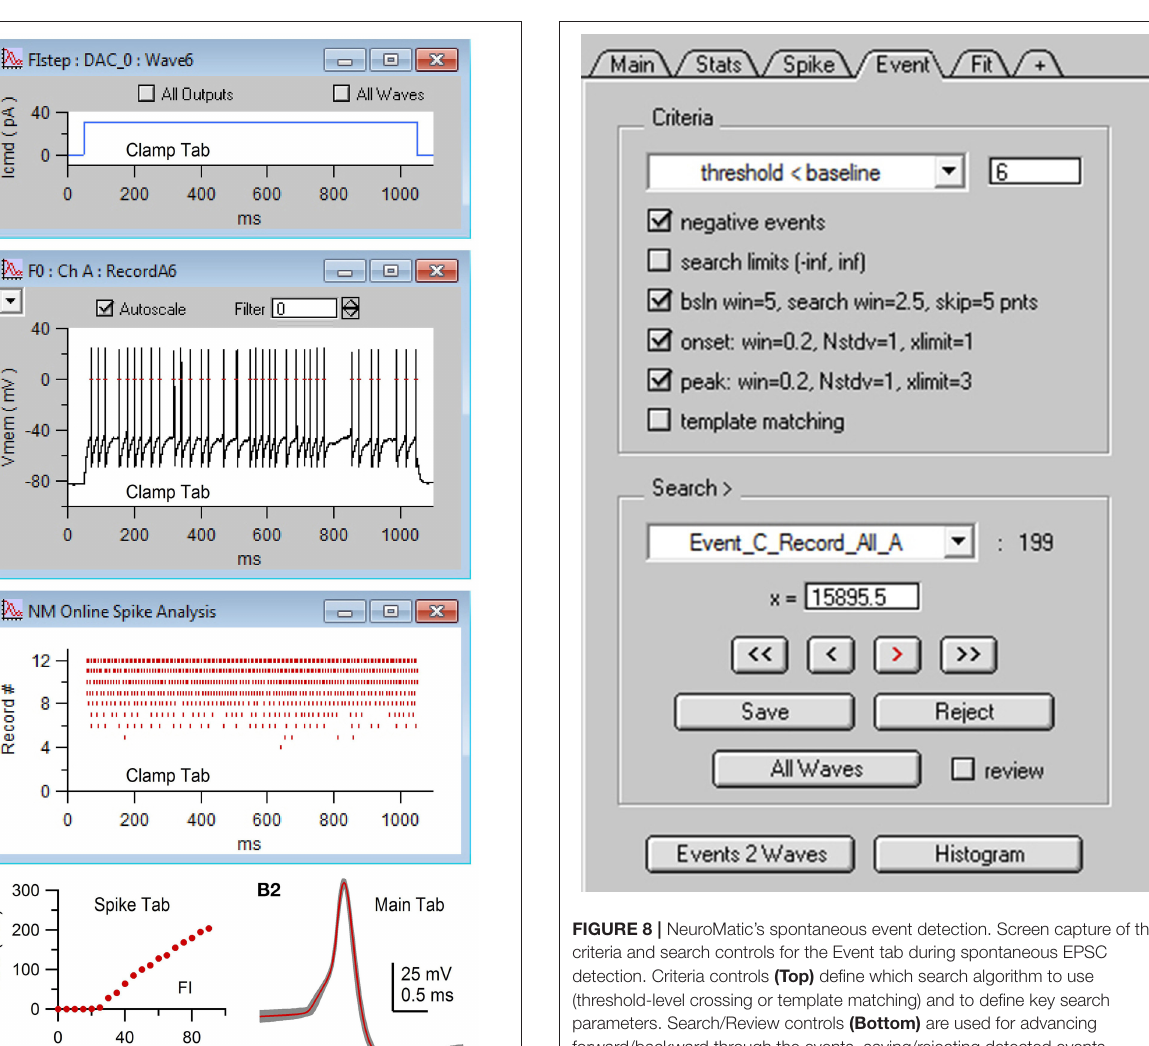
( Figure 9A1 , red dash). The threshold level is a fixed value below baseline (e.g., 6 pA), but can also be the number of standard deviations (STDVs) below baseline (N STDV < baseline). Here,